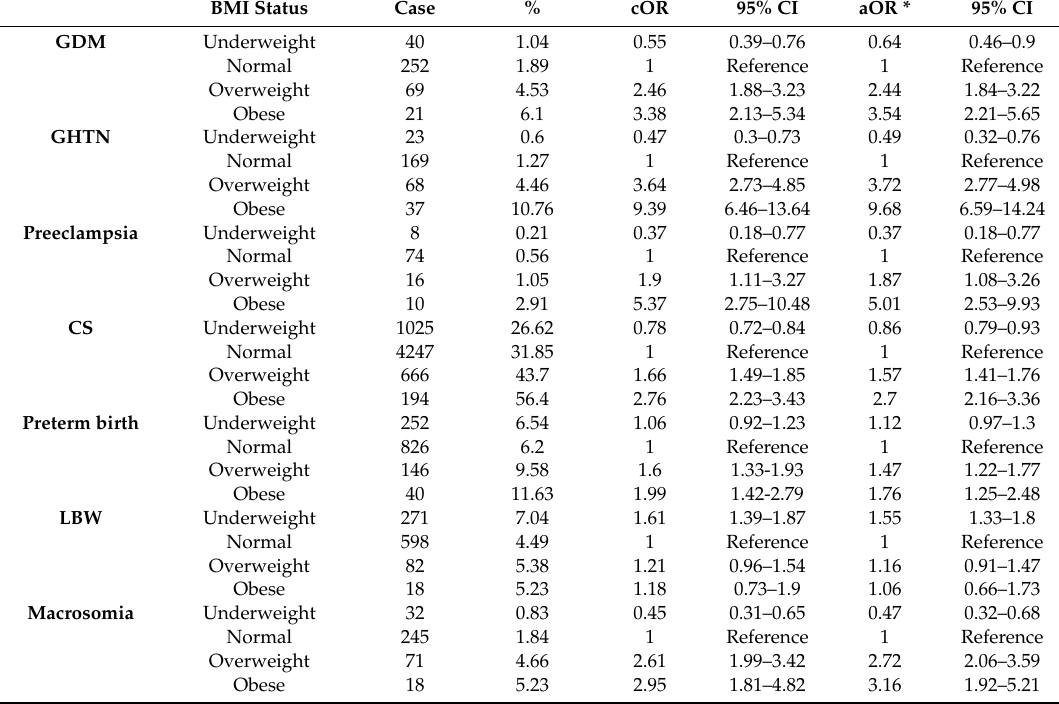
Table 2. Association between maternal prepregnancy body mass index (BMI) status and perinatal